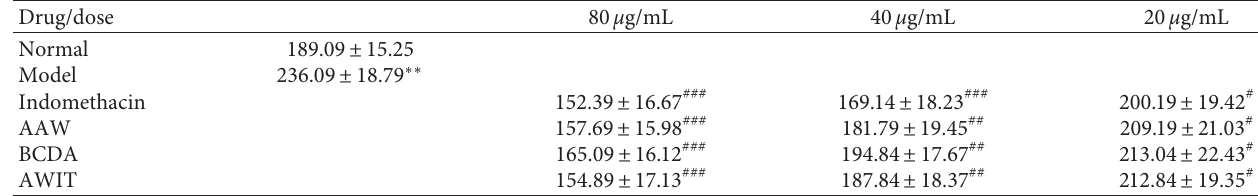
Scheme 1: LACs generated from agaroterol on heating. Table 2: LPS-induced release of TNF- α in RAW264.7 cells.